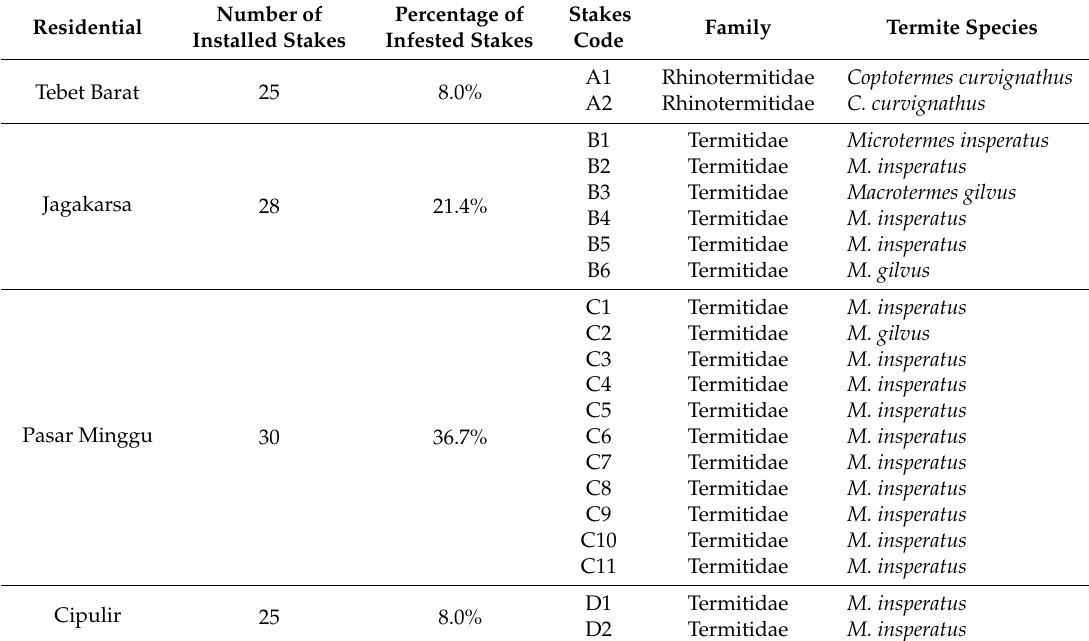
Table 1. Diversity of subterranean termites from four residences in South